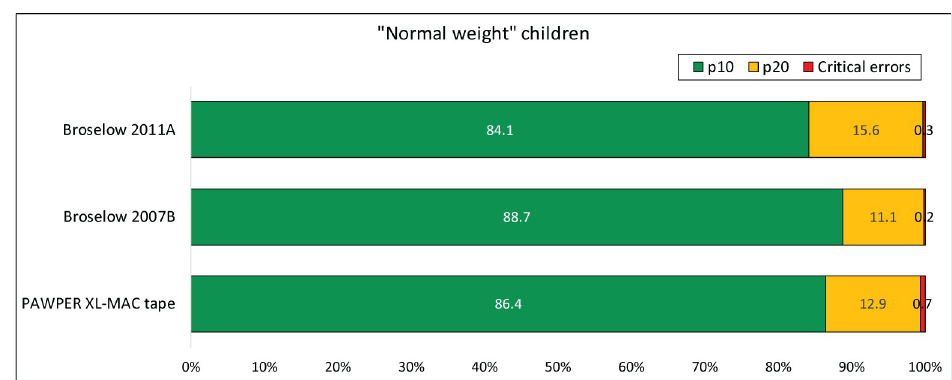
Fig 4. Accuracy of the three systems in “normal weight” children. The chart shows the proportion of weight estimations falling within 10% and 20% of actual weight (p10 and p20 respectively) as well as the proportion of critical weight estimation errors ( > 20% error) for children with a BMI-for-age Z-score between -1.4 and 1.4. This subgroup data was not available for the Ralston method as it information was not presented in the original publication. The McNemar test was significant at the p < 0.001 level for every comparison of p10 and p20. However, the differences were not clinically important.